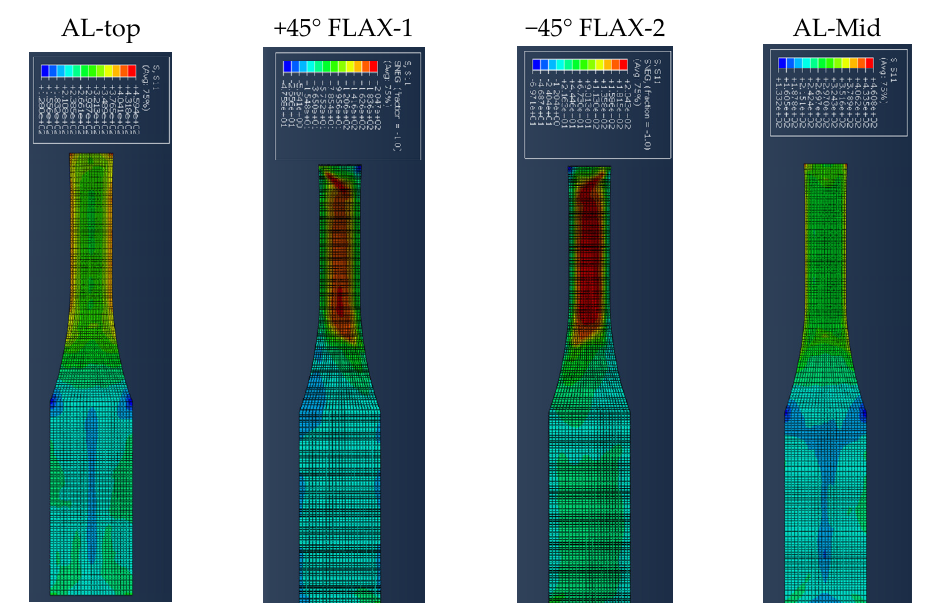
Figure 14. Stress distribution of each top layer of laminate C at 3 mm displacement.